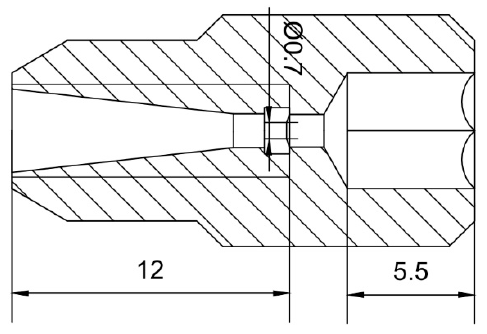
Figure 1. Two ‐ dimensional geometric model of the nozzle. Figure 1. Two-dimensional geometric model of the